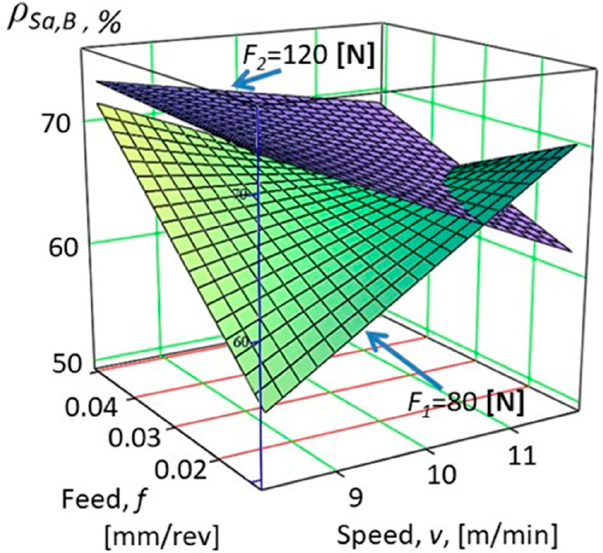
Figure 12. Improvement of the change of surface roughness ρ Sa , B on specimens marked B (see Equation (10)).